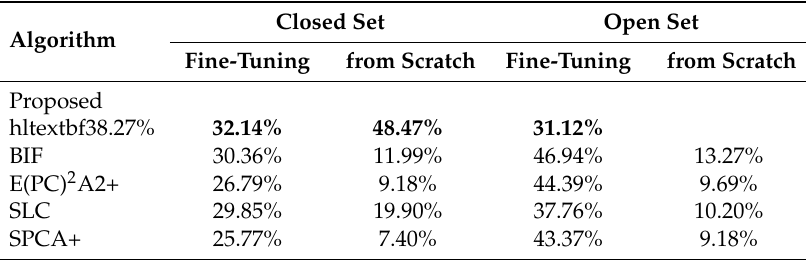
Table 2. Face recognition rate of SphereFace [65] on CAS-PEAL-R1 with various data augmentation